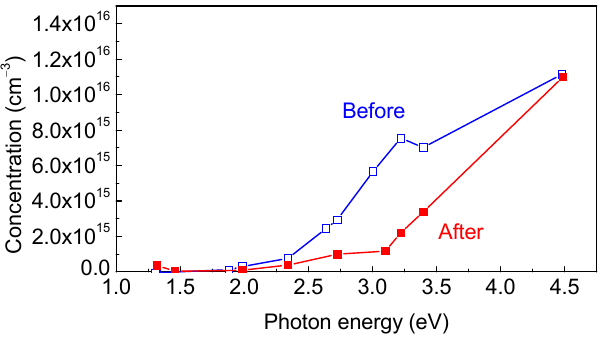
Figure 16. LCV spectra measured before and after irradiation.